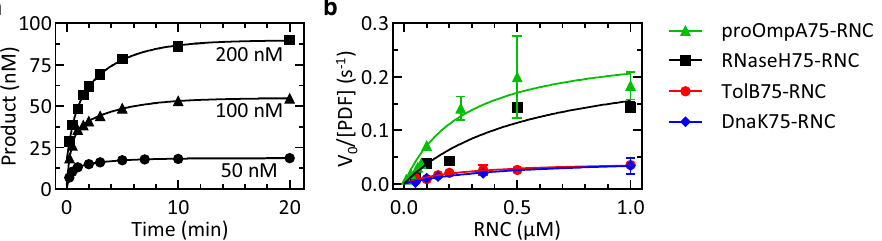
Figure 1. RNC deformylation at multiple turnover conditions. ( a ) Deformylation time courses measured at limiting PDF concentration (10 nM) and increasing concentration of RNaseH75-RNC, as indicated. ( b ) Michaelis–Menten plot. Initial velocities ( V o ) are normalized by the concentration of PDF (10 nM for RNaseH75-RNC, TolB75-RNC, DnaK75-RNC; 1 nM for proOmpA75-RNC). Michaelis–Menten fits (lines) yield the parameters summarized in Table 1. Error margins indicate standard errors determined from linear fitting of individual time courses.